Question: Summarize what this figure shows in one sentence.
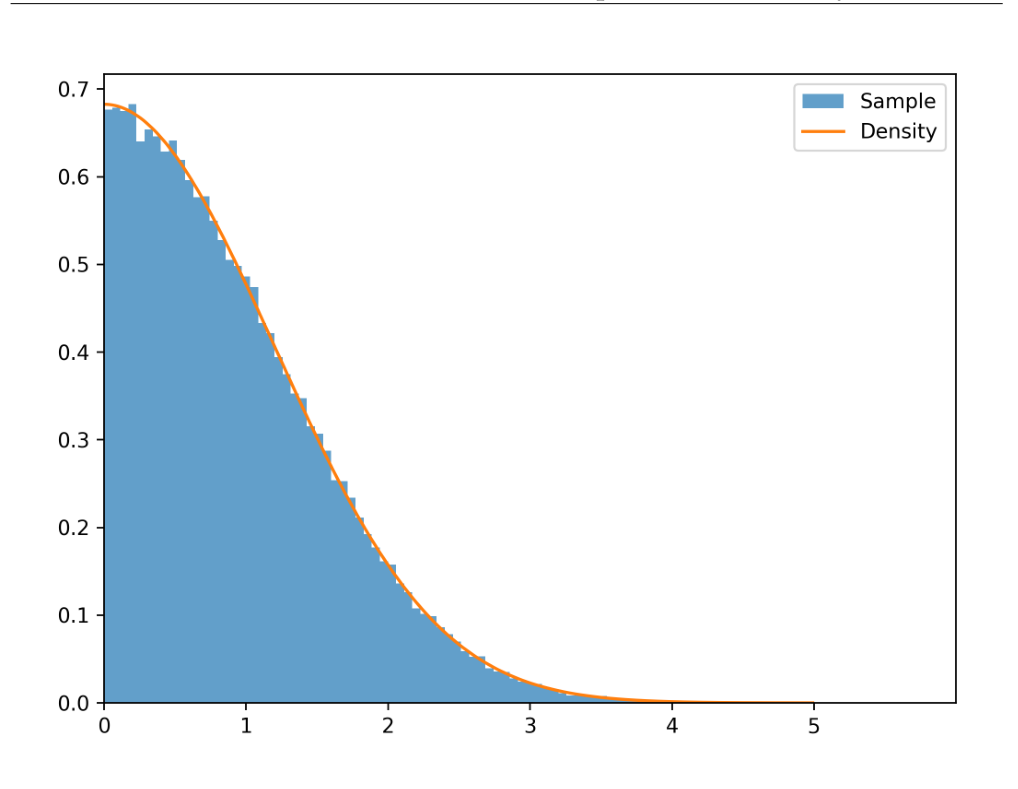
Answer: 1: Probability density functions of two normal distributions with mean 0, but with different standard deviations. The higher the standard deviation (and, hence, the variance), the higher the probability of obtaining extreme values.